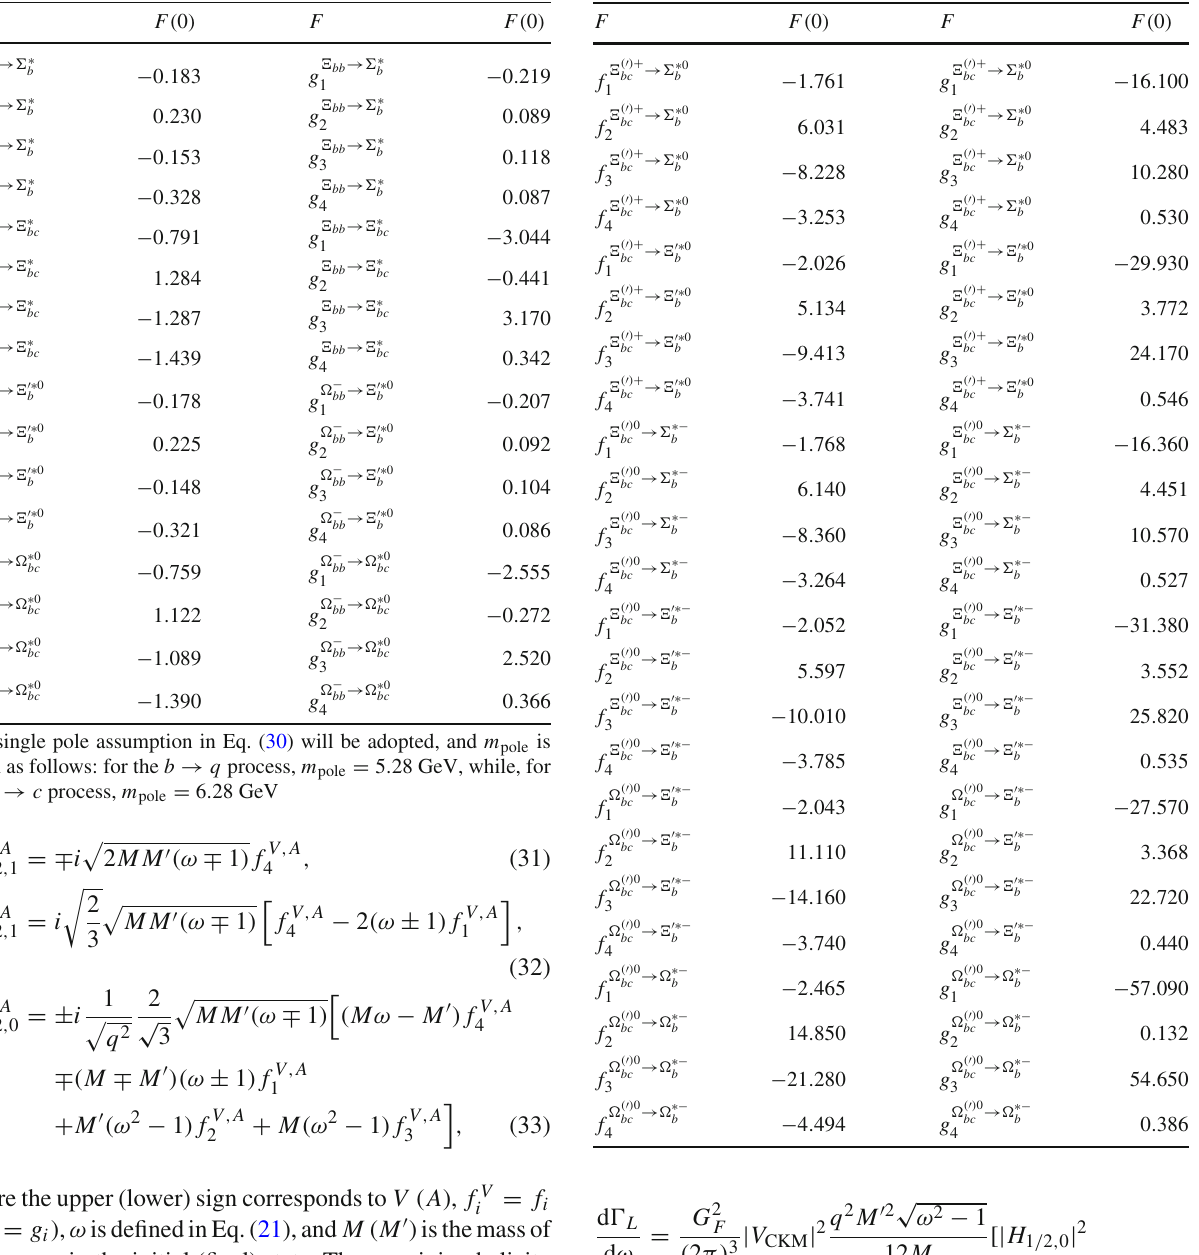
Table 7 Values of form factors at q 2 = 0 for the bb sector Table 8 Same as Table 6 but for the bc ( (cid:3) ) sector with c quark